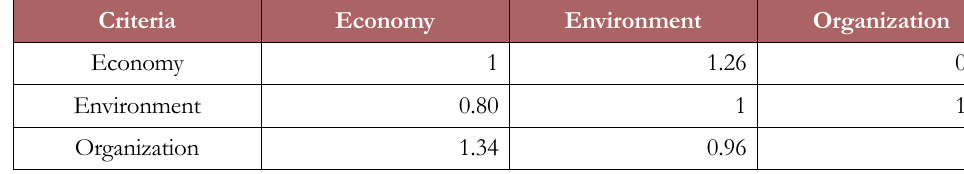
Table 3. Pairwise Comparison Matrix